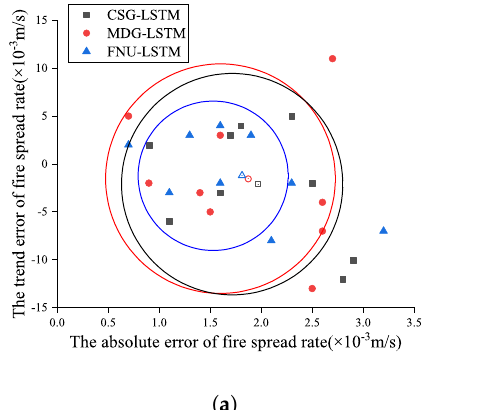
Figure 10. The scattered particle points and their gravity centers of fire and wind prediction using 3 kinds of LSTM-based models, respectively. The circles represent density of the error distribution. ( a ) The scattered plot on predicting fire spread rate. ( b ) The scattered plot on predicting wind